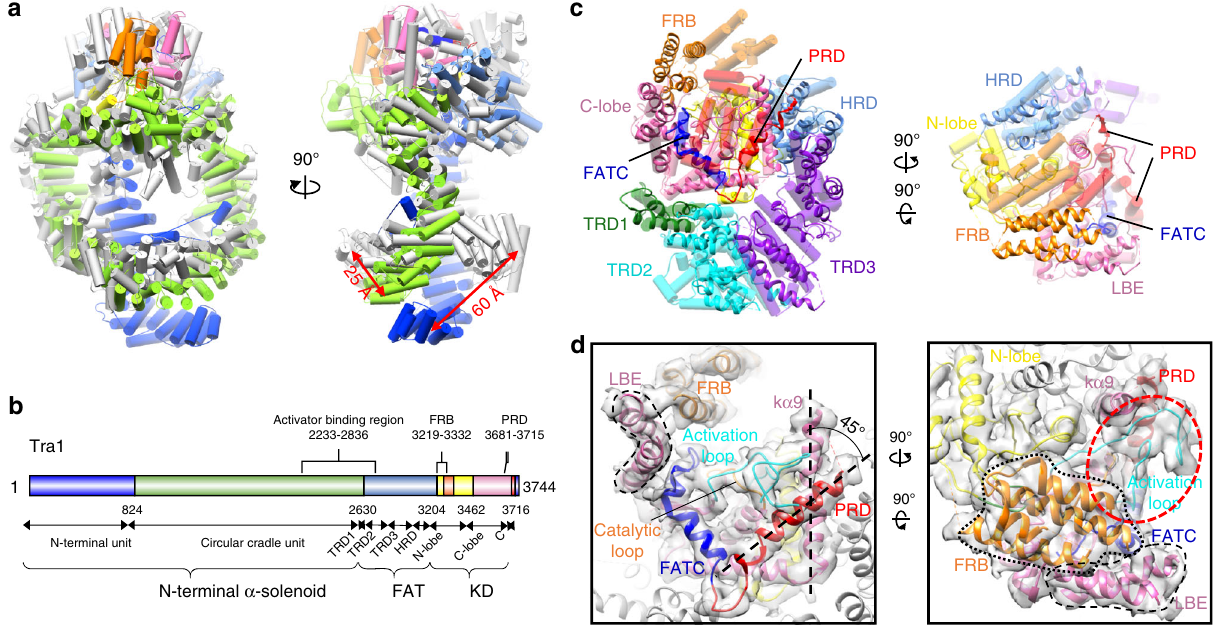
Fig. 3 Structure of the Tra1 in the TEEAA assembly. a Structure comparison of Tra1 with DNA-PKcs. The Tra1 subunit is color-coded by domain assignment as panel b and aligned with the crystal structure of DNA-PKcs (gray, PDB ID: 5LUQ). Signi fi cant differences in the two structures are observed in the N- terminal HEAT repeats. The N-terminal unit of Tra1 moves inwards by 60 Å, while the circular cradle unit moves a smaller distance by 25 Å. b A schematic representation highlighting the functional domains of Tra1. Three units of Tra1: N-terminal HEAT repeat (the N-terminal unit and the circular cradle unit), the FAT (TRD1, 2, 3 and HRD), and the kinase regions are labeled. The activator binding region, the FRB insertion and the PRD domain are labeled above the schematic. c Structural comparison of the FATKIN region of Tra1 and DNA-PKcs. Tra1 FATKIN is shown in ribbon diagram model and DNA-PKcs FATKIN is shown in transparent pipes. The domain organization and color assignment are the same as Supplementary Fig. 7. d Two detailed views of the active site of Tra1, with the N-lobe is shown in yellow, the C-lobe in hot pink, the FRB insertion in orange, PRD in red, and FATC in blue. The cryo-EM density is displayed in transparent surface. The activation loop is colored in cyan and the catalytic loop in orange. The FAT domain is shown in gray. The LBE domain is highlighted in black dashed lines, while the FRB insertion in dotted lines. PRD moves outwards by 45° relative to the k α 9. The red dashed circle highlights the highly extended and exposed activation